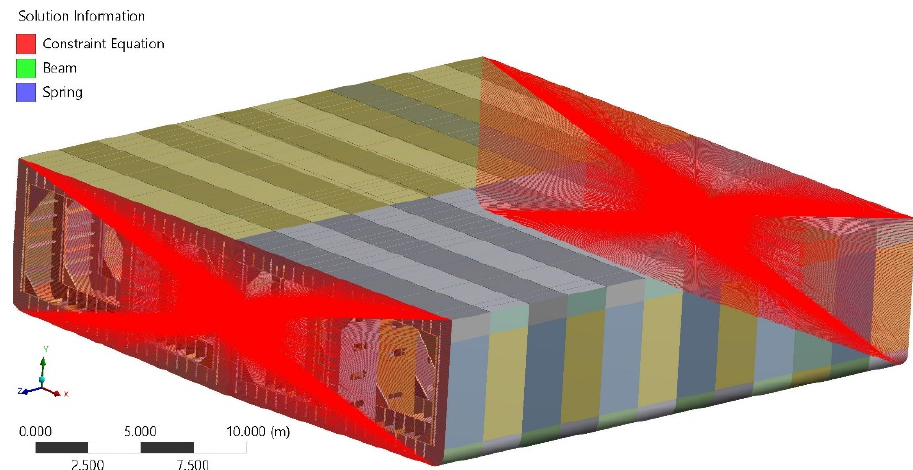
Figure 9. Multipoint constraints used in the FEM model of the barge midship section with independent point on the neutral axis.